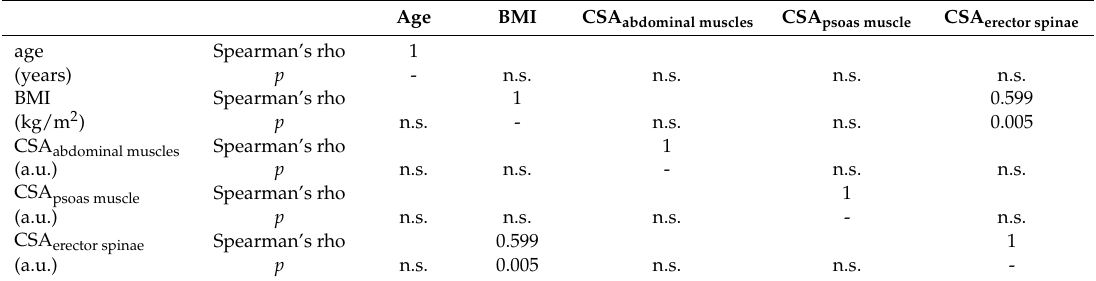
Table 4. This table illustrates the results of the correlation of age, body mass index (BMI), and cross-sectional area (CSA) in the abdominal muscles, psoas muscle, and erector spinae in